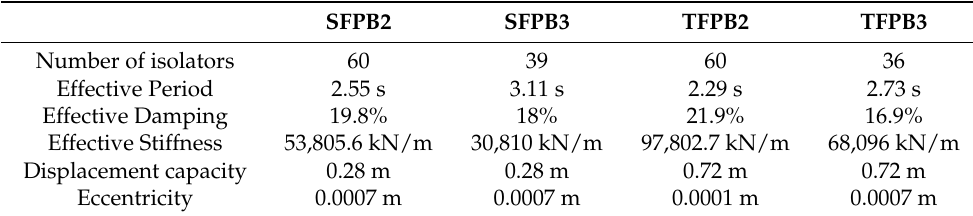
Table 2. Optimization results for all optimized isolations configurations.